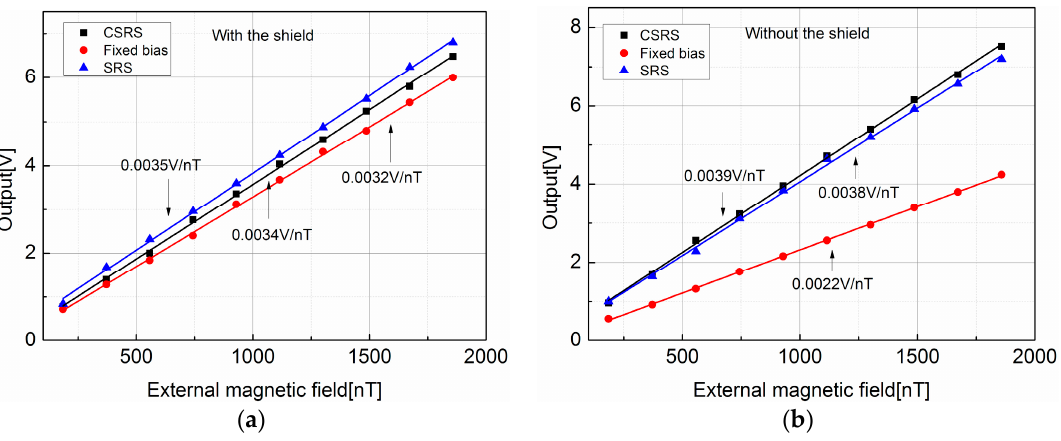
Figure 10. Output characteristic curves of the GMI sensor, ( a ) with the magnetic shield; ( b ) without the magnetic shield.